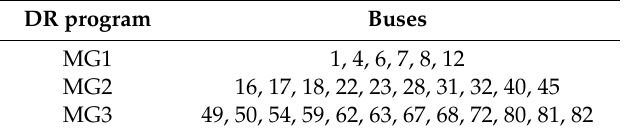
Table 2. Supported areas of Demand Response (DR) programs in each Microgrid (MG).